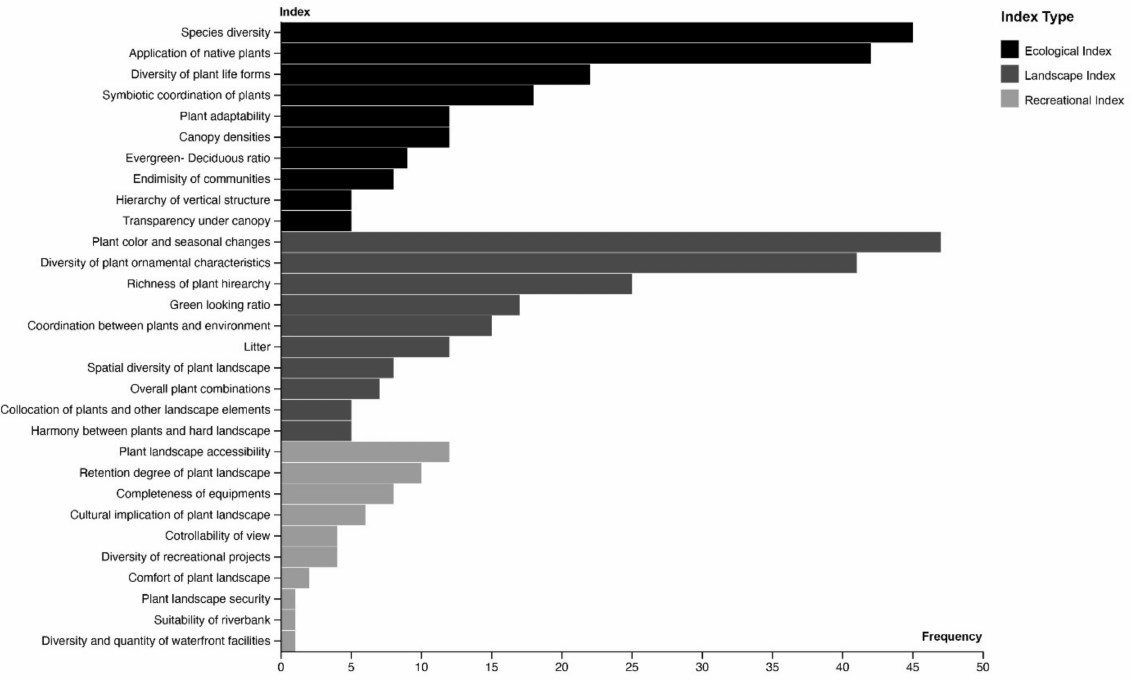
Figure 1. Evaluation indicators of riparian landscape from the literature review (source: